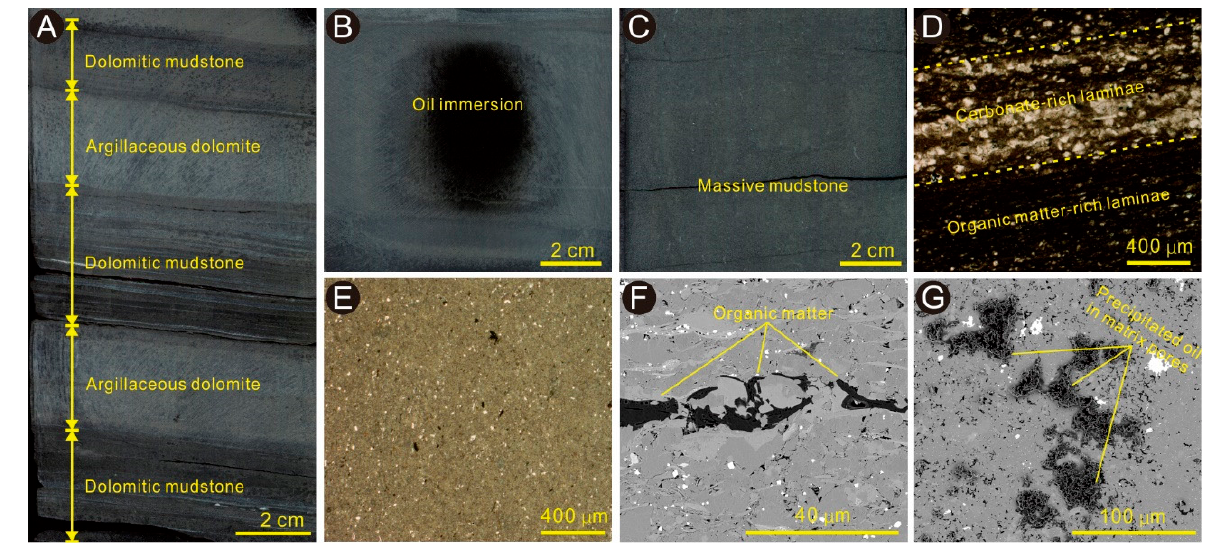
Figure 3. Lithological, geochemical, and mineralogical profiles of the LXF II Oil Bed in the Jianghan Basin. Clastic = Quartz + Feldspar + Clay.